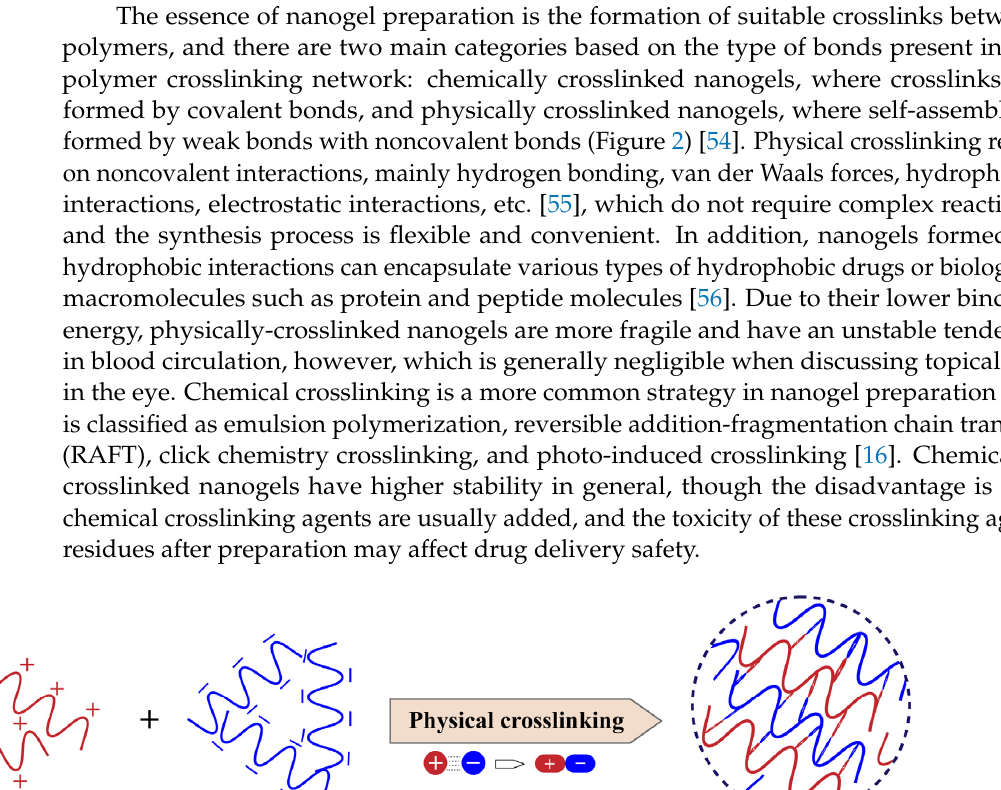
stability. Meanwhile, the latter approach is particularly suitable for preparing nanogels based on natural polymers. Natural polymers with biocompatibility and biodegradability, such as methylcellulose, hyaluronic acid, chitosan, and sodium alginate, have a wide range of applications in the biomedical field, including tissue engineering, antimicrobial applications, and drug delivery [58–63]. Some nanogels are synthesized by graft polymerization and hydrophobic modification of natural polymer molecular chains, followed by further crosslinking in aqueous solutions. For example, the potential toxicity and nonbiodegradability of the synthetic polymer N-isopropylacrylamide (PNIPAAM) restrict its application as a nanogel. However, nanogels are formed by combining PNIPAAM with natural polymers, which improve not only biocompatibility and biodegradability but also drug delivery efficiency [64,65] . 3.3. Stimuli-Responsive Nanogels Stimuli-responsive behavior is the ability to show sensitivity to endogenous biochemical stimuli and exogenous physical stimuli. Nanogels based on stimuli- responsive models, also known as “Smart” nanogels [66–68], have emerged as a promising prospect in drug delivery systems. As shown in the figure (Figure 3), various types of smart nanogels are outlined, and depending on the disease category and environmental change, these are possible methods currently used for controlled drug release [19]. Smart nanogels are generally prepared with the same technology as normal nanogels, except that the former is created by polymerizing desired functional monomers